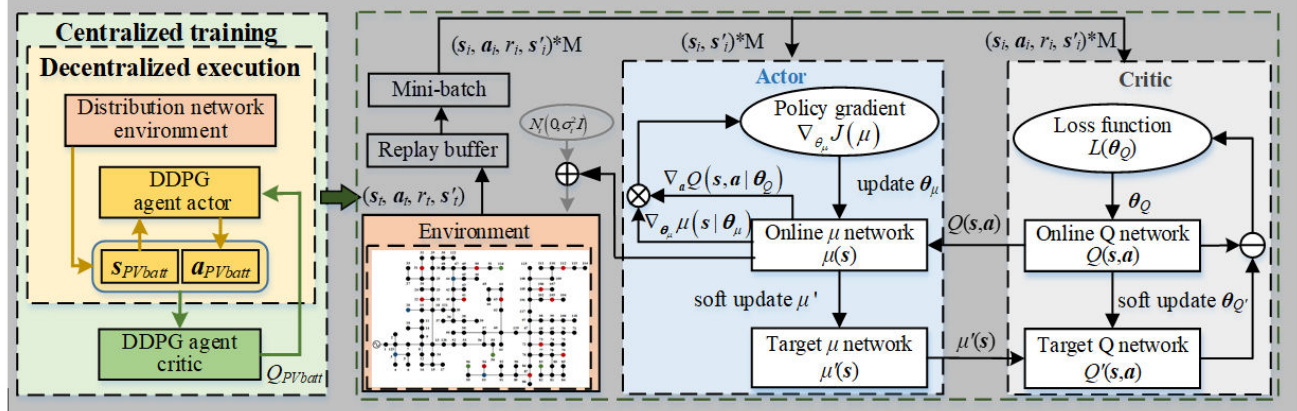
Figure 2. The control of PV inverters and batteries based on DDPG agent.